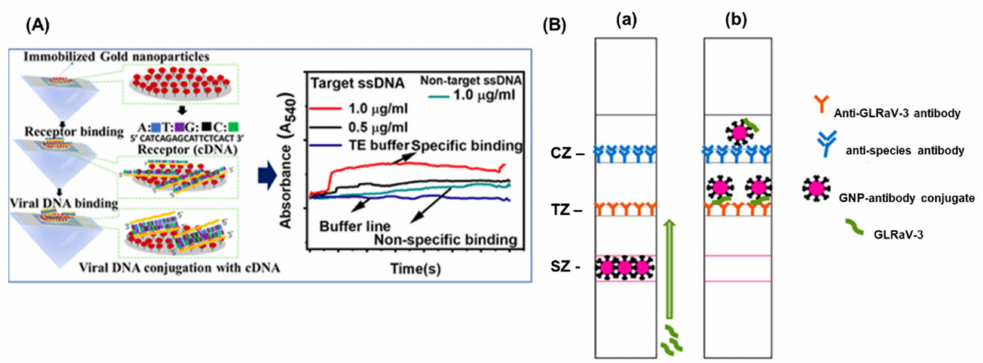
Figure 4. ( A ) Schematic representation of the detection of Chili Leaf Curl Virus using Attenuated Total Reflection-Mediated Localized Surface-Plasmon-Resonance-Based Optical Platform ( B ) Lateral Flow Immunoassay for Rapid Detection of Grapevine Leafroll-Associated Virus. ( a ) is before capturing the GLRaV-3 and ( b ) after binding of GLRaV-3 with antibody. The images are adopted from the references